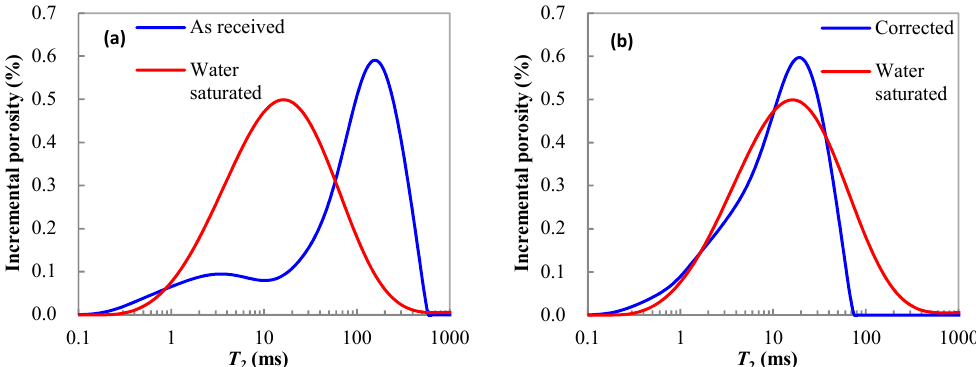
Figure 8. Sample M2: ( a ) T 2 distributions for “as received” state and water saturated state; ( b ) Comparison of corrected and measured T 2 distributions for water-saturated state.